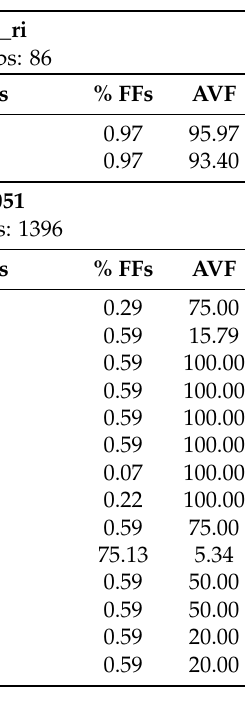
Table 6. Hardened versions of the designs under test, synthesized with XST.